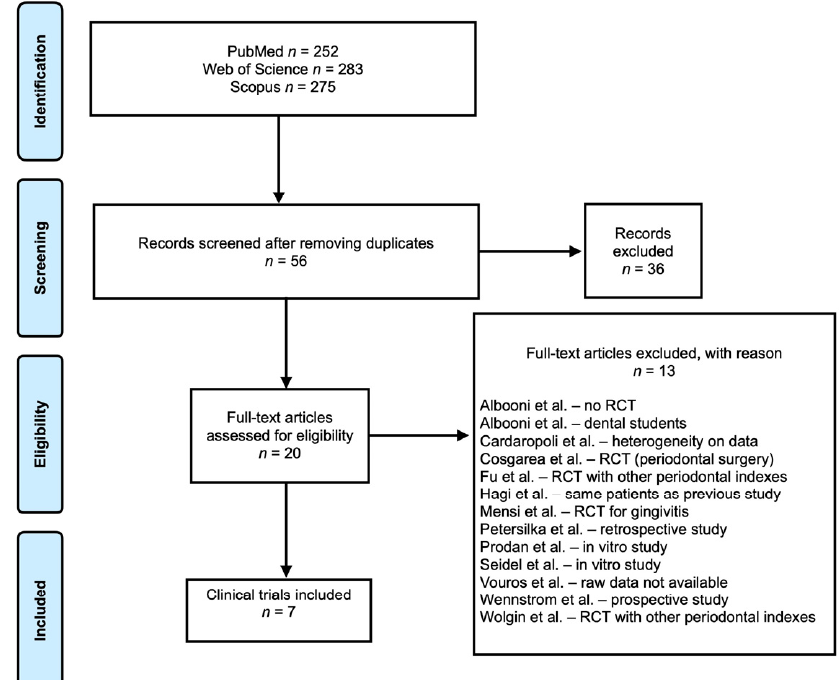
Figure 1. Prisma flowchart.